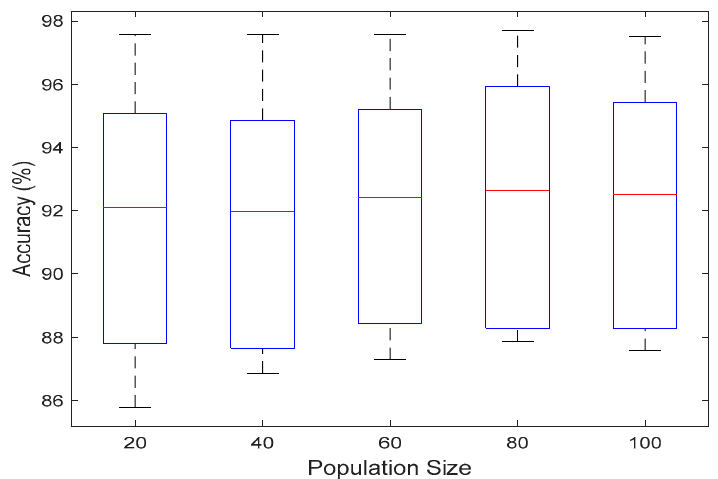
Figure 4. Boxplot of BPSODE with five different population sizes across 10 subjects.